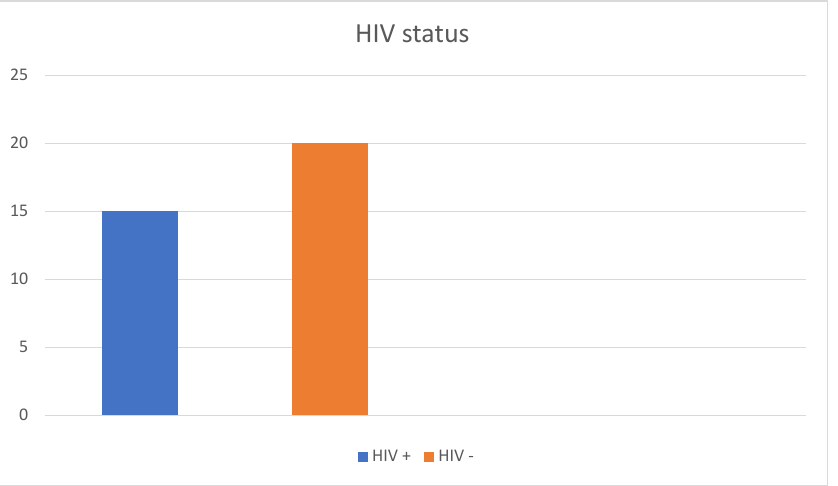
Table 1. Distribution of patients based on sex, sexual preferences and presence of HIV infection. Figure 4. Prevalence of HIV in our patient cohort. Nearly half (42.8%) of the patients were HIV